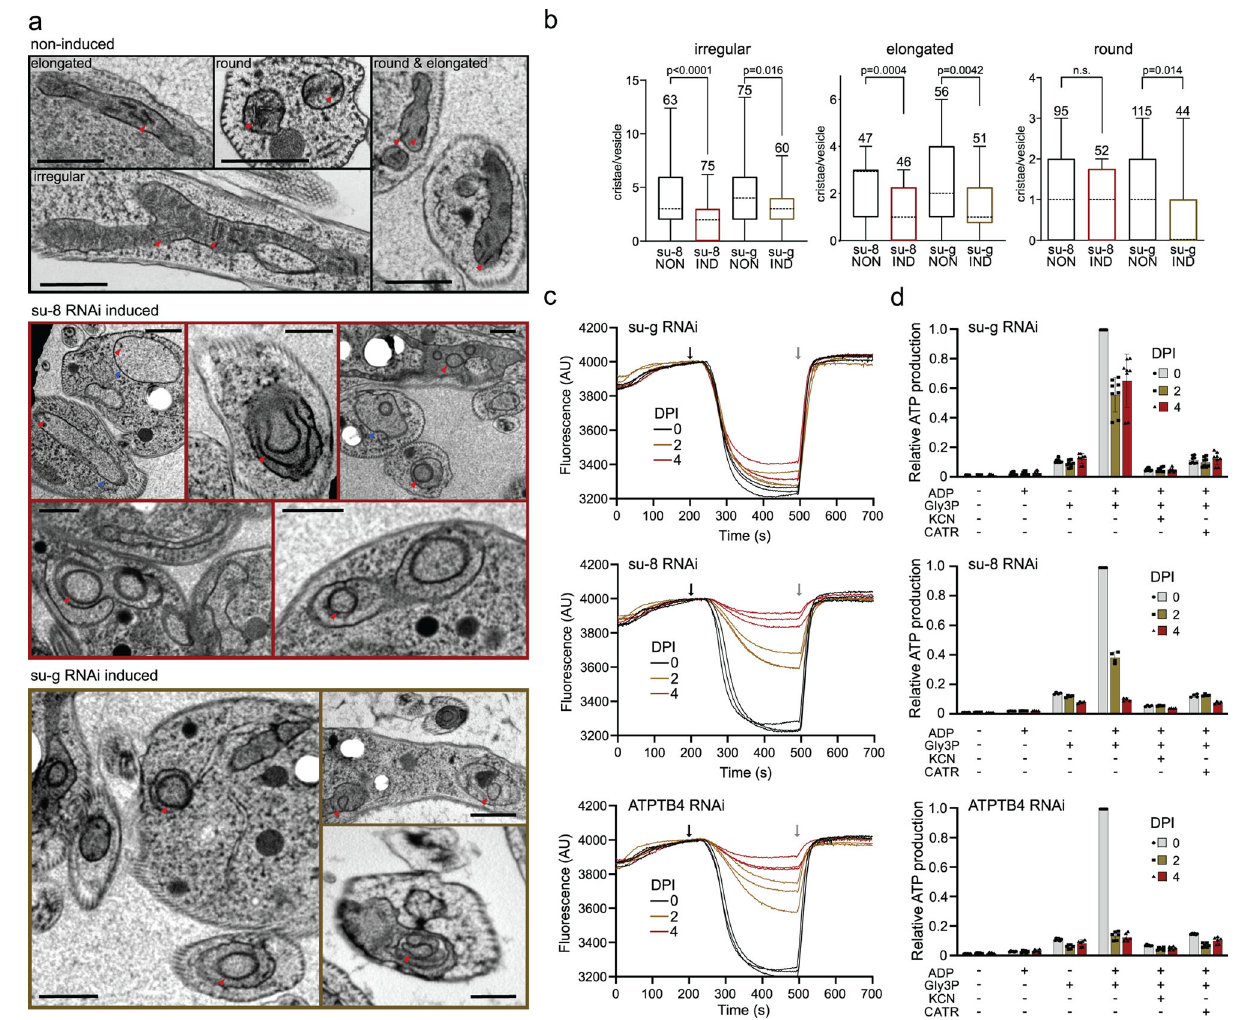
Fig. 7 | Monomerization of ATP synthase by subunit- g knockdown results in aberrant mitochondrial ultrastructure but does not abolish catalytic activity. a Transmissionelectronmicrographsofsectionsofnon-inducedor4daysinduced RNAi cell lines. At least 70 micrographs were obtained in each category. Mito- chondrial membranes and cristae are marked with blue and red arrowheads, respectively. Top panel shows examples of irregular, elongated and round cross- sections of mitochondria quanti fi ed in ( b ). Scale bars: 500nm. b Cristae numbers per vesicle from indicated induced (IND) or non-induced (NON) cell lines counted separately in irregular, elongated and round mitochondrial cross-section. Boxes and whiskers show 25th to 75th and 5th to 95th percentiles, respectively. The